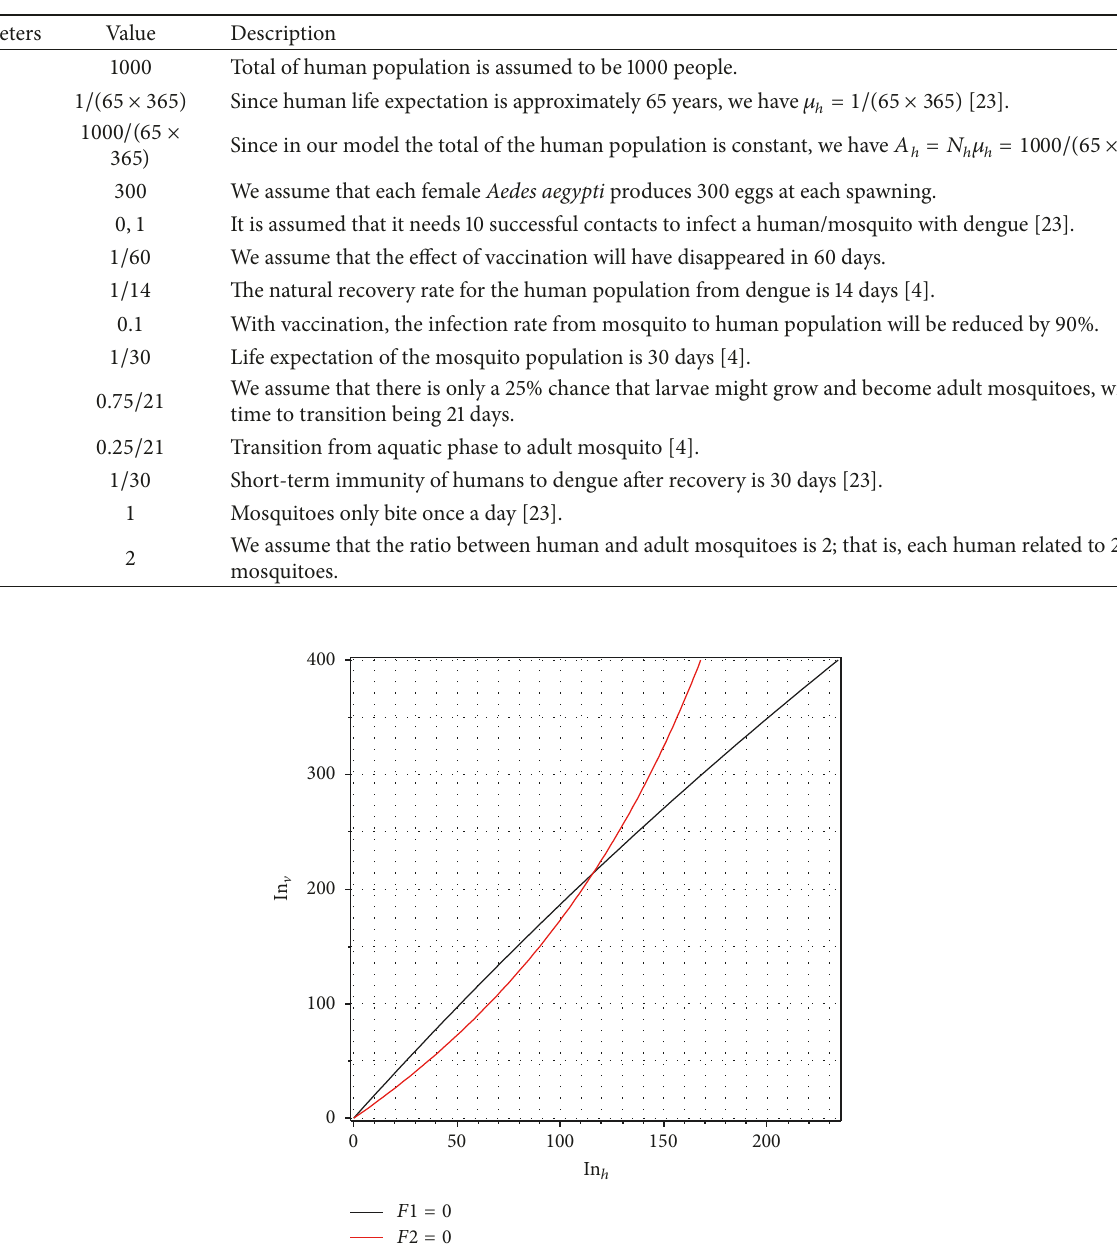
Table 1: Parameters values.